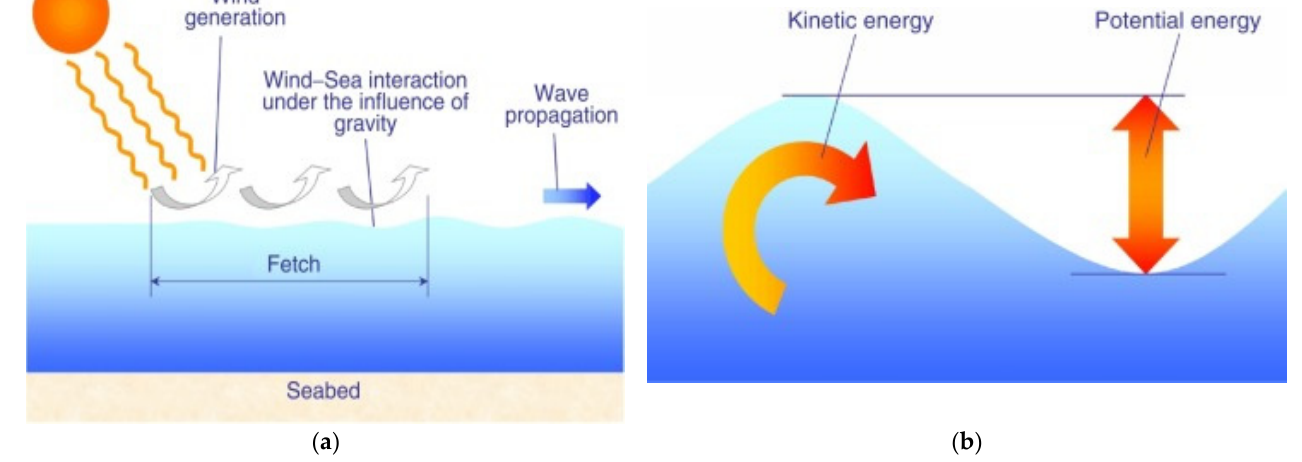
Figure 6. Ocean wave generation: ( a ) Wave generation induced by wind and ( b ) energy components in the wave (adopted from [86] with license no.